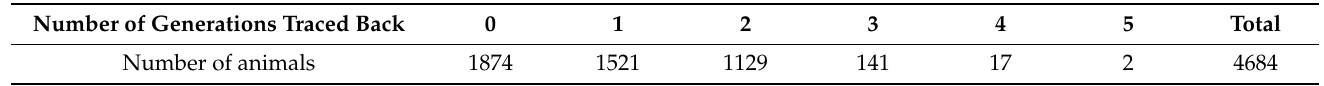
Table 1. Number of animals in each generation traced back from the 1874